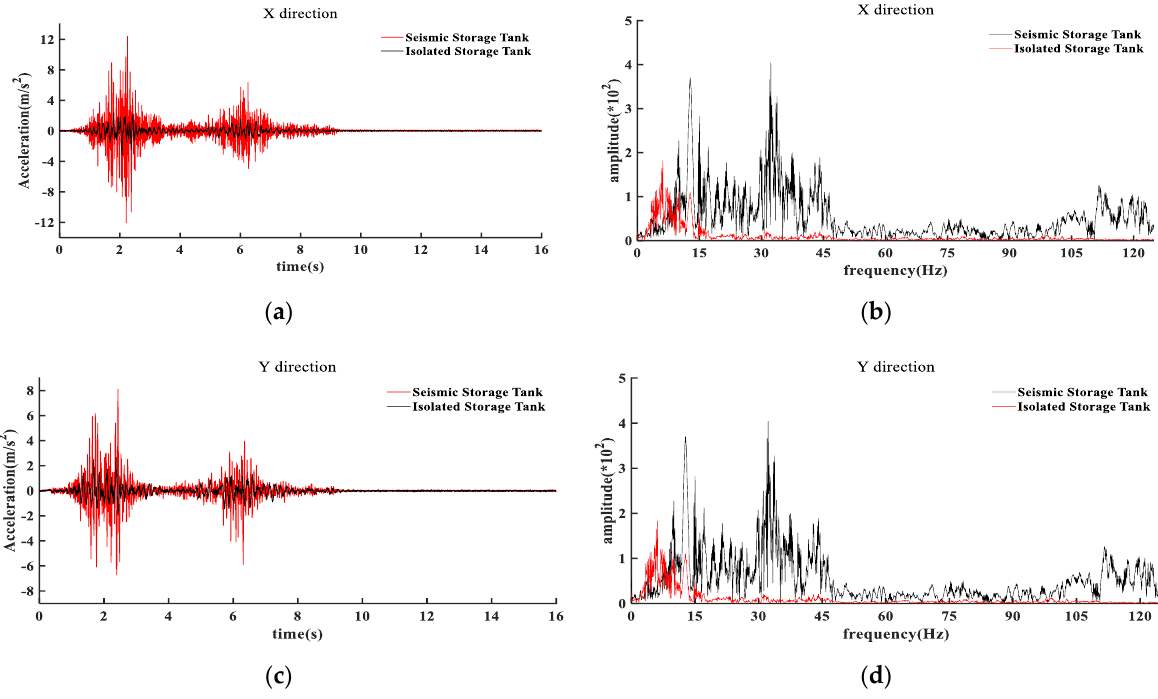
Figure 7. Wolong wave (XYZ direction, 0.75 g): ( a ) acceleration time history curves in the X-direction; ( b ) spectrum characteristic curve in the X-direction; ( c ) acceleration time history curves in the Y-direction; ( d ) spectrum characteristic curve in the Y-direction.